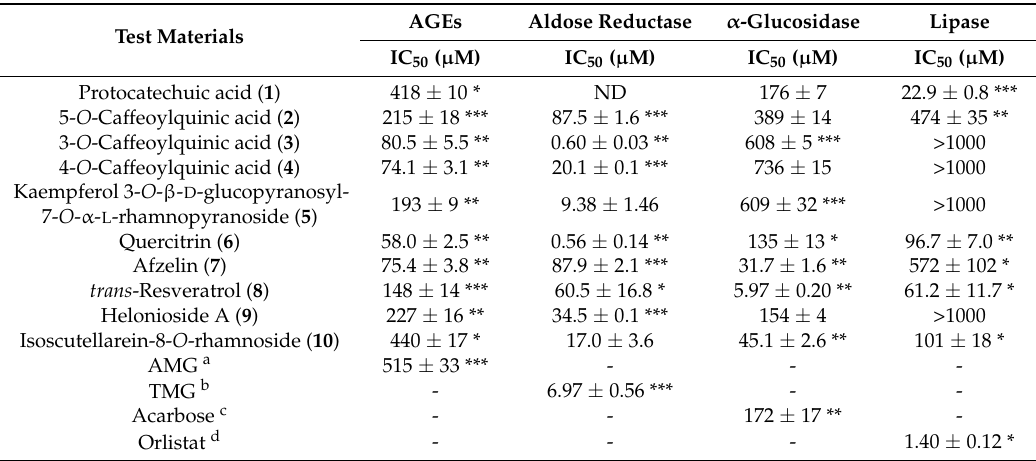
Table 3. Inhibitory effect of SCS-isolated compounds 3 . Inhibition of AGEs formation, AR, α -glucosidase and lipase activities by isolated compounds from SCS. AGEs Aldose Test Materials